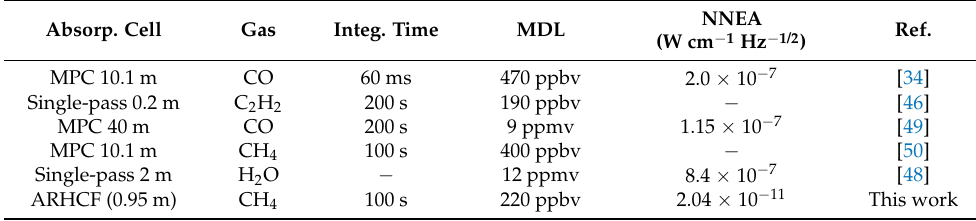
Table 1. Comparison of the performance of gas sensors utilizing QEPTS. Absorp. Cell Gas Integ. Time